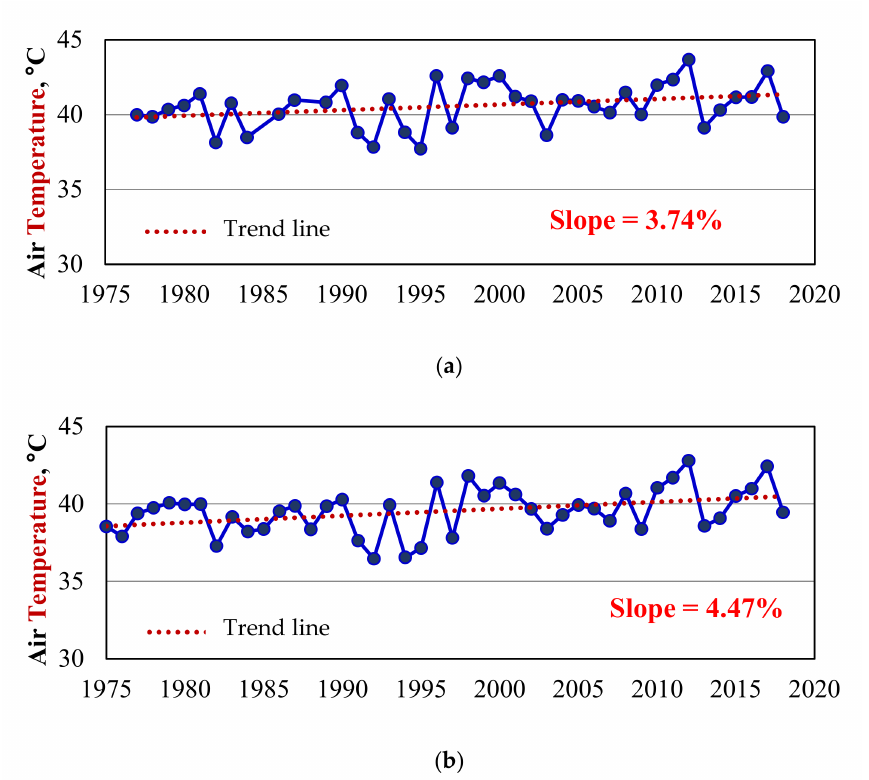
Figure 9. Yearly Average Near-surface temperature at 11:00 a.m. from July 15 to August 5. ( a ) Sharjah International Airport; ( b ) Dubai International